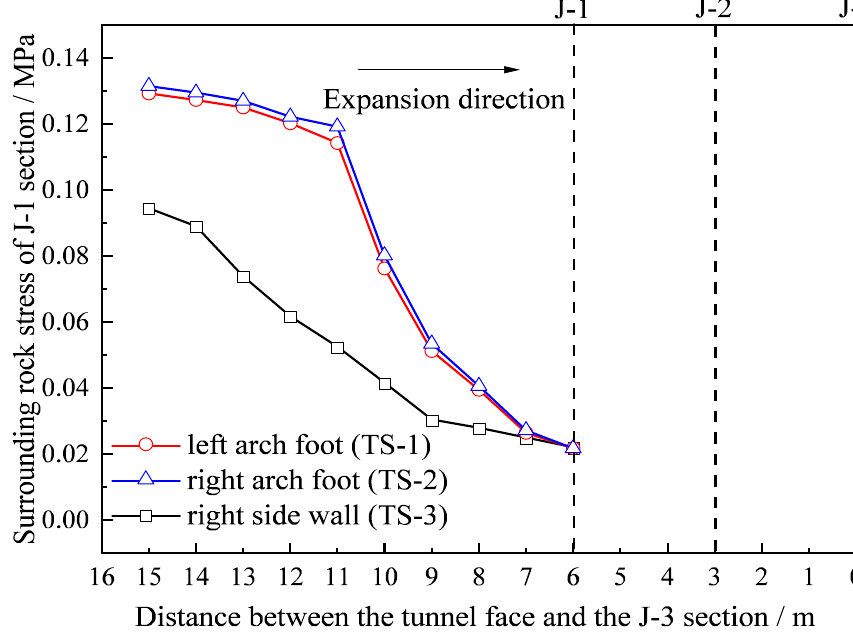
Figure 4. Stress gauge installation at the site.